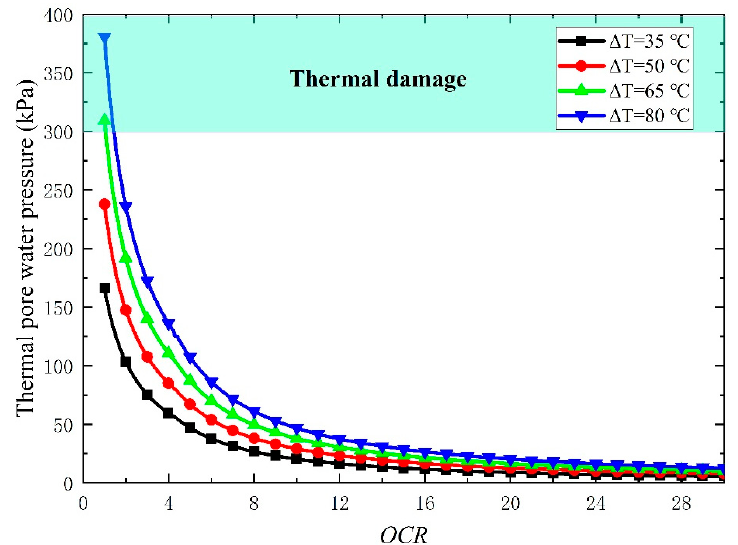
Figure 3. Evolution of the thermal pore water pressure with OCR under different thermal loadings.